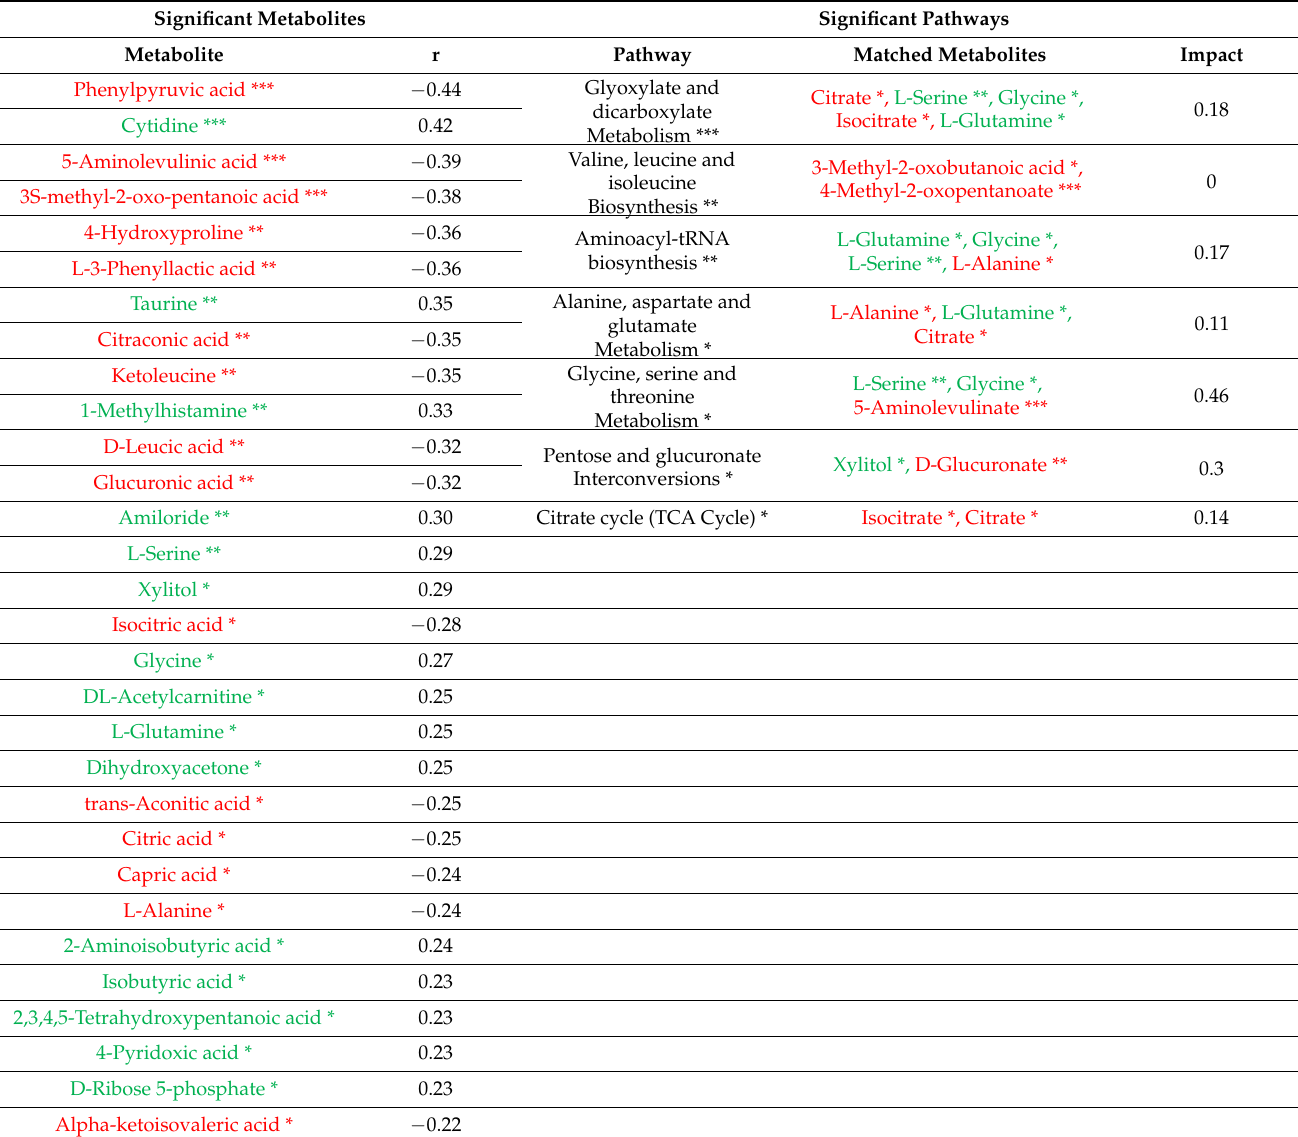
Table 7. Metabolites and their pathways which correlate with autism